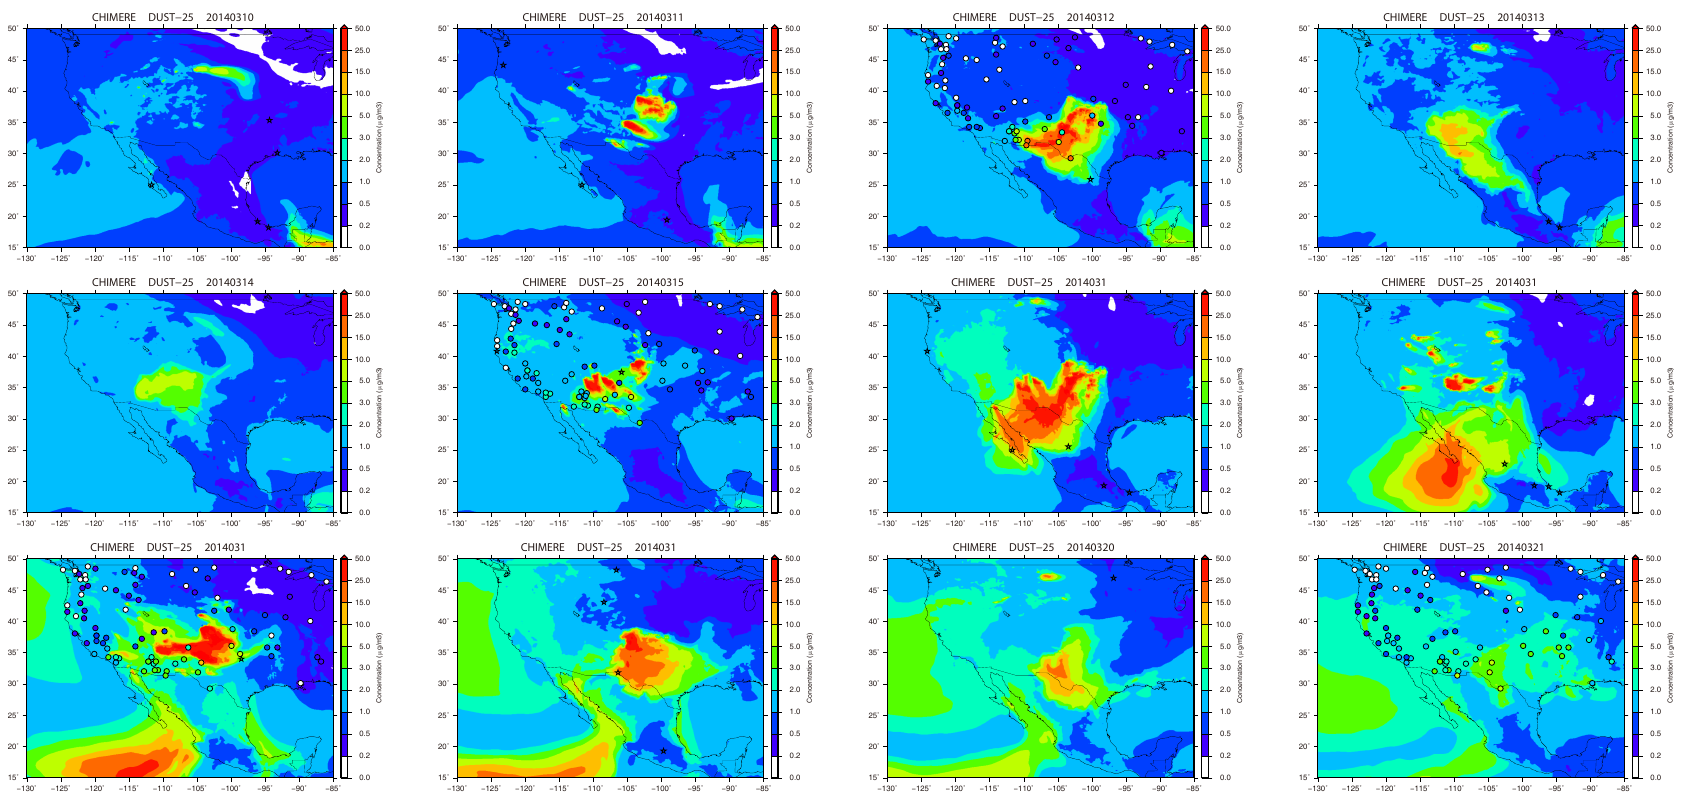
Figure 11. Modeled daily mean dust concentrations in the fine fraction of PM with CHIMERE versus observational data at selected IMPROVE stations (below 2000 m a.s.l.) from 10 to 21 March 2014. The circles represent the PM 2.5 observational data. Manned “dust” SYNOP observations are displayed at WMO stations (“star” symbol), a symbol is plotted if at least one observation is reported for a given